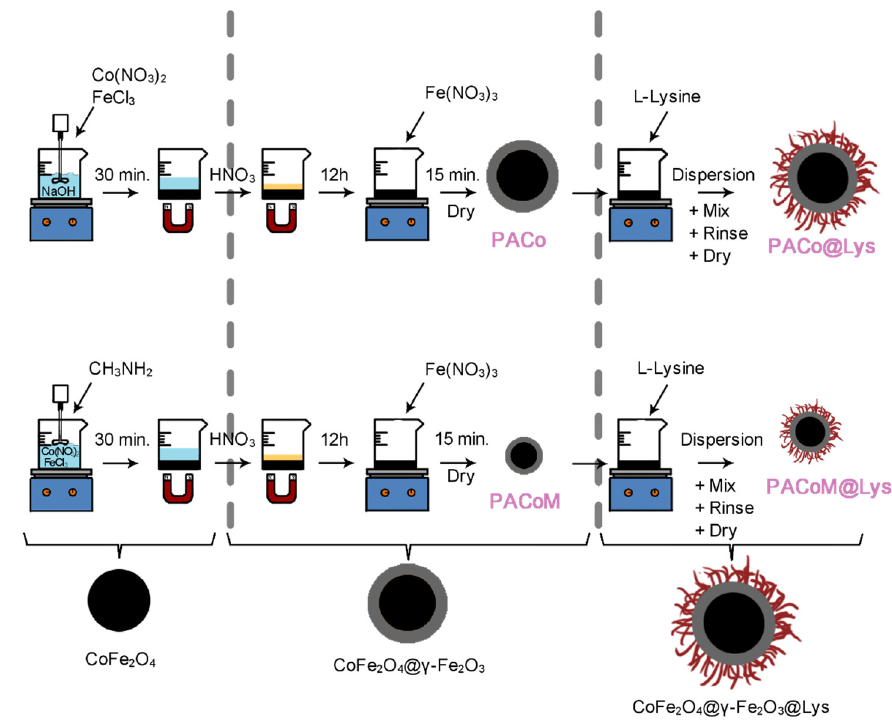
Figure 1. Scheme of elaboration of the magnetic nanoadsorbent samples.